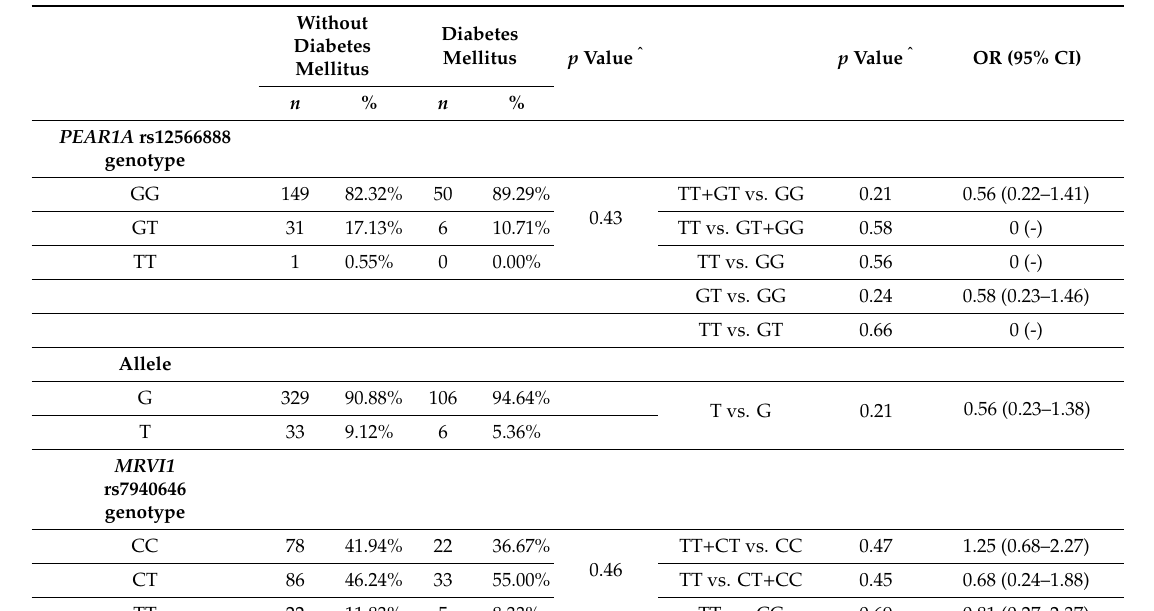
Table 9. Distributions of the PEAR1A , MRVI1 , and GP6 genotypes and alleles in unstable angina patients with and without diabetes mellitus (DM). Without Diabetes Diabetes Mellitus